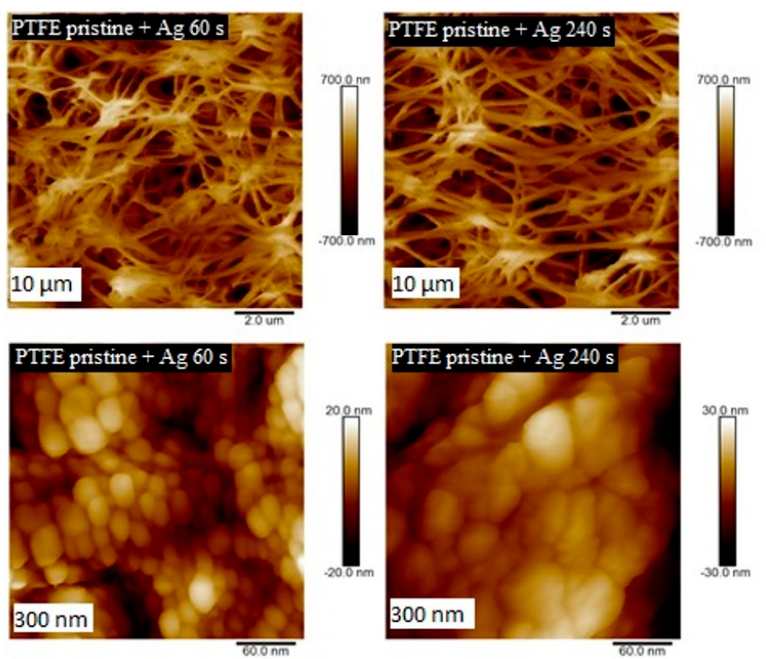
Figure 3. Surface morphology study by AFM for pristine PTFE samples with Ag deposited for 60 and 240 s (scans are of 10 × 10 µm 2 a 300 × 300 nm 2 ). The structures of PTFE and PFA with surface Ag layers, as well as plasma-modified samples, were studied by AFM. Information on the size and shape of arisen surface struc- tures was obtained in the form of 2D and 3D images. The first set of PTFE samples was sputtered with silver with the deposition time of 60 and 240 s. When images with a size of 300 × 300 nm 2 are compared, it is evident that with growing silver deposition time, the size of silver nanoclusters deposited on PTFE polymer increased (Figure 3). Similar prop- erties were detected also for metalized PFA samples, on which a silver layer was depos- ited for 30–240 s. When comparing the surface structures of these samples on a 300 nm scan (Figure 4), it is evident, that the deposition time of metal affects the size of forming structures. The longer the deposition time, the greater the surface structures were de- tected. This effect was confirmed by comparing the surface roughness of PFA samples with sputtered silver. The surface roughness of PFA samples with sputtered silver in- creased with the growing deposition time of the metal.